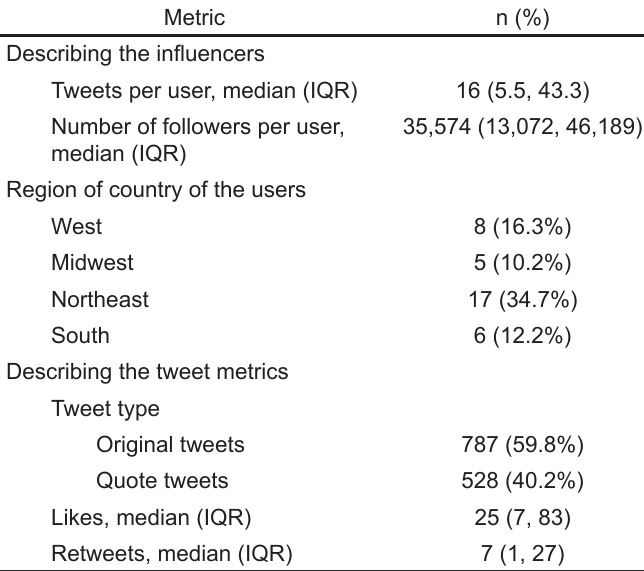
Table 1. Describing the emergency medicine influencers and tweet metrics (N =